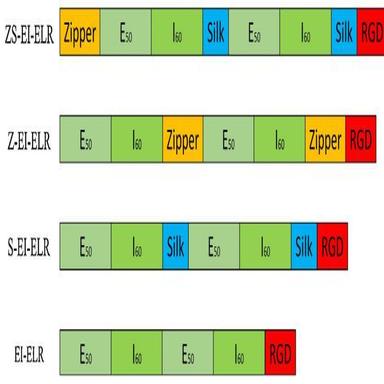
Graphical scheme of the composition of the used recombinamers.